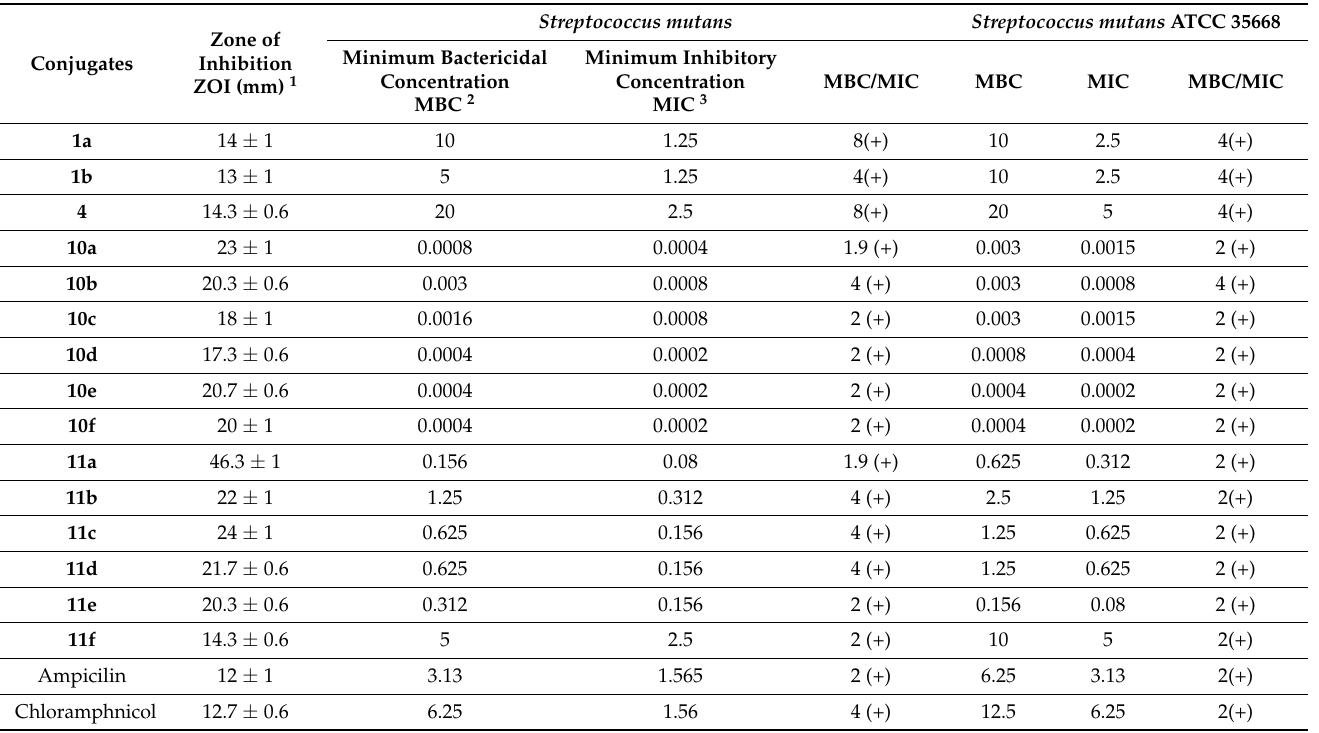
Table 3. Antibacterial activity of conjugates 10a – f and 11a – f against Streptococcus mutans clini- cal isolate.